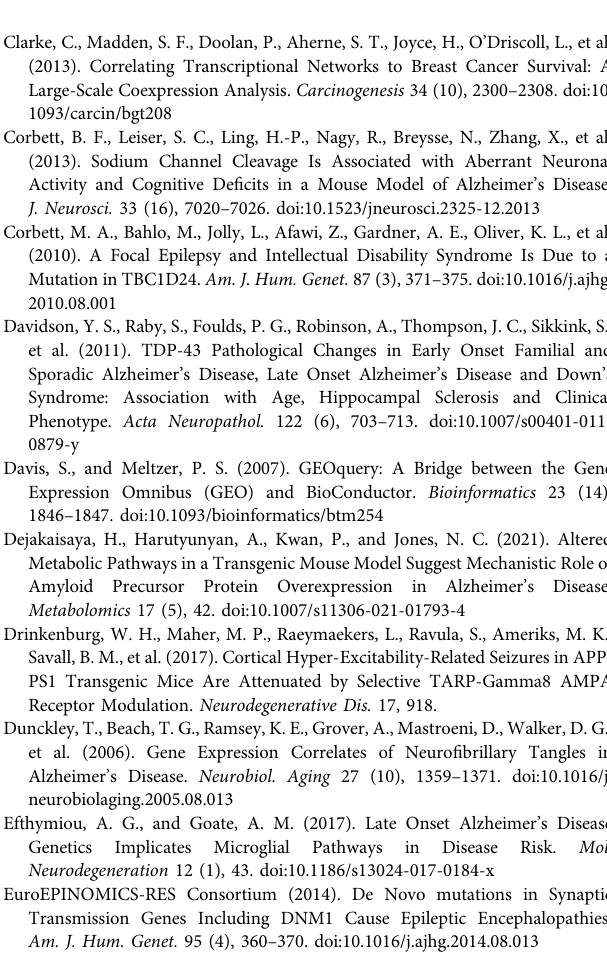
Supplementary Figure S1 | The scale free topology fi t, mean connectivity and hierarchical clustering tree of all samples in TLE dataset. Supplementary Figure S2 | The scale free topology fi t, mean connectivity and hierarchical clustering tree of all samples in AD dataset. Supplementary Figure S3 | The scale free topology fi t, mean connectivity and hierarchical clustering tree of all samples in NDC dataset. Supplementary Figure S4 | Heatmap detailing the relationship between the datasets (x axis) and all detected modules (y axis) and in the (A) AD and (B) NDC networks. Each block in the heatmap shows the direction (red: positive, blue: negative), strength (Pearson correlation coef fi cient, top number) and FDR-adjusted signi fi cance of the Pearson correlation (in brackets) of the given module to each dataset that was used to generate the